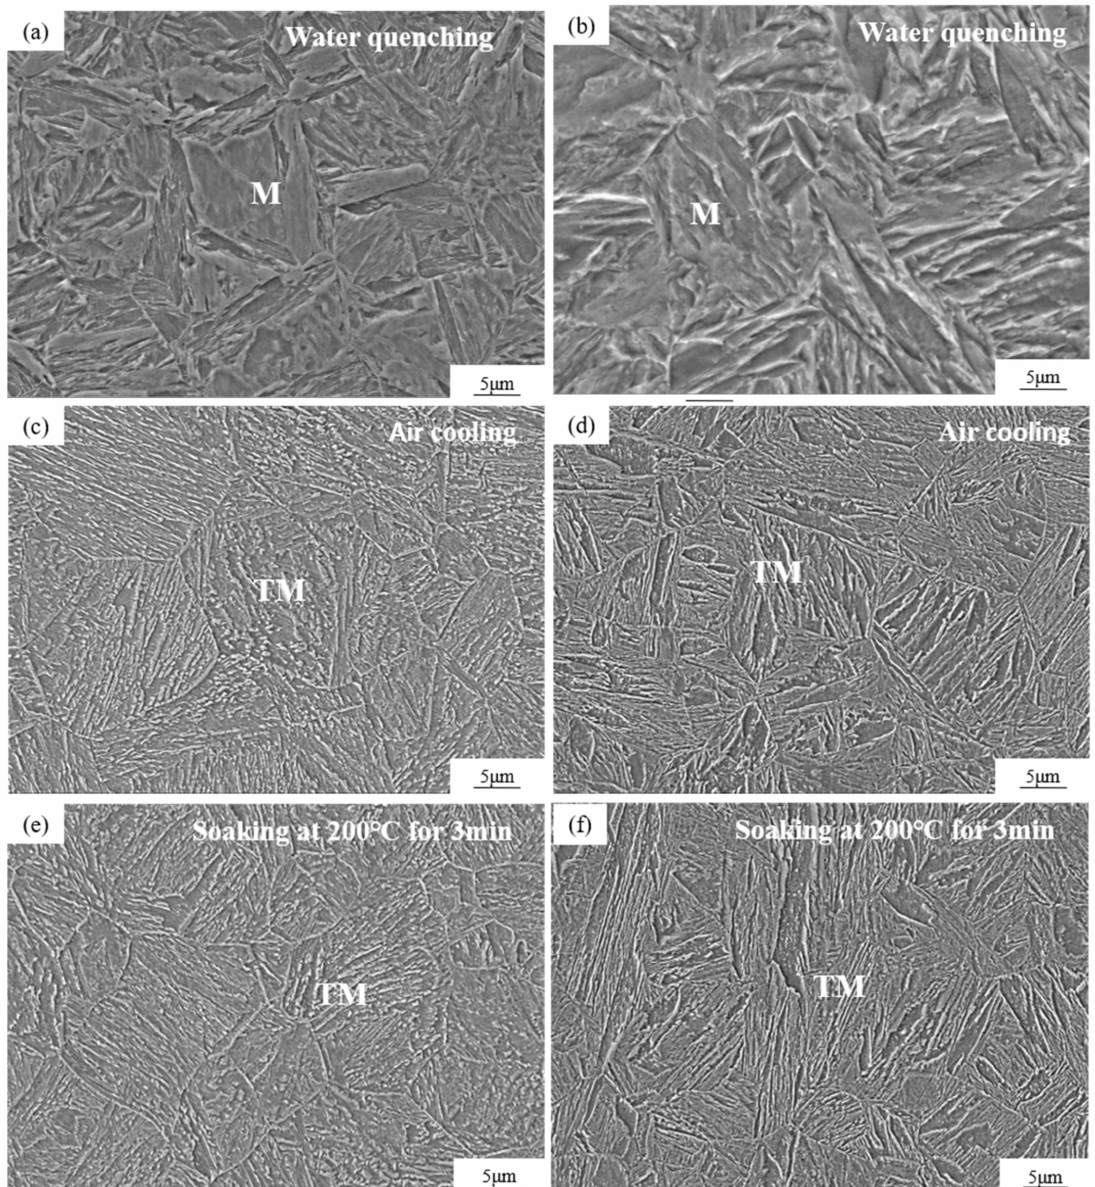
Figure 3. Microstructures of steel A ( a , c , e ) and steel B ( b , d , f ) heated at 880 ◦ C for 3 min then treated with different cooling